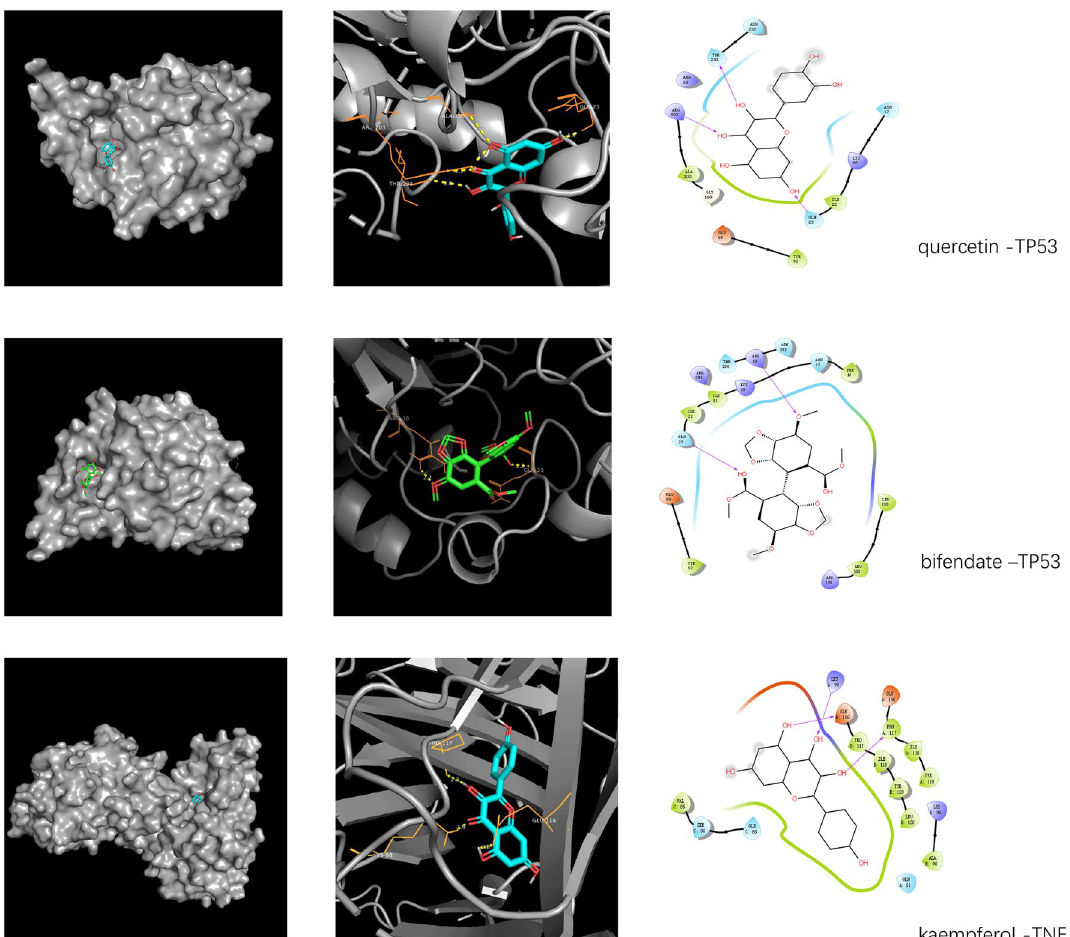
Figure 9. Molecular docking patterns. The yellow lines represent the hydrogen bond interaction force, which is the main force promoting molecule binding with the active site.